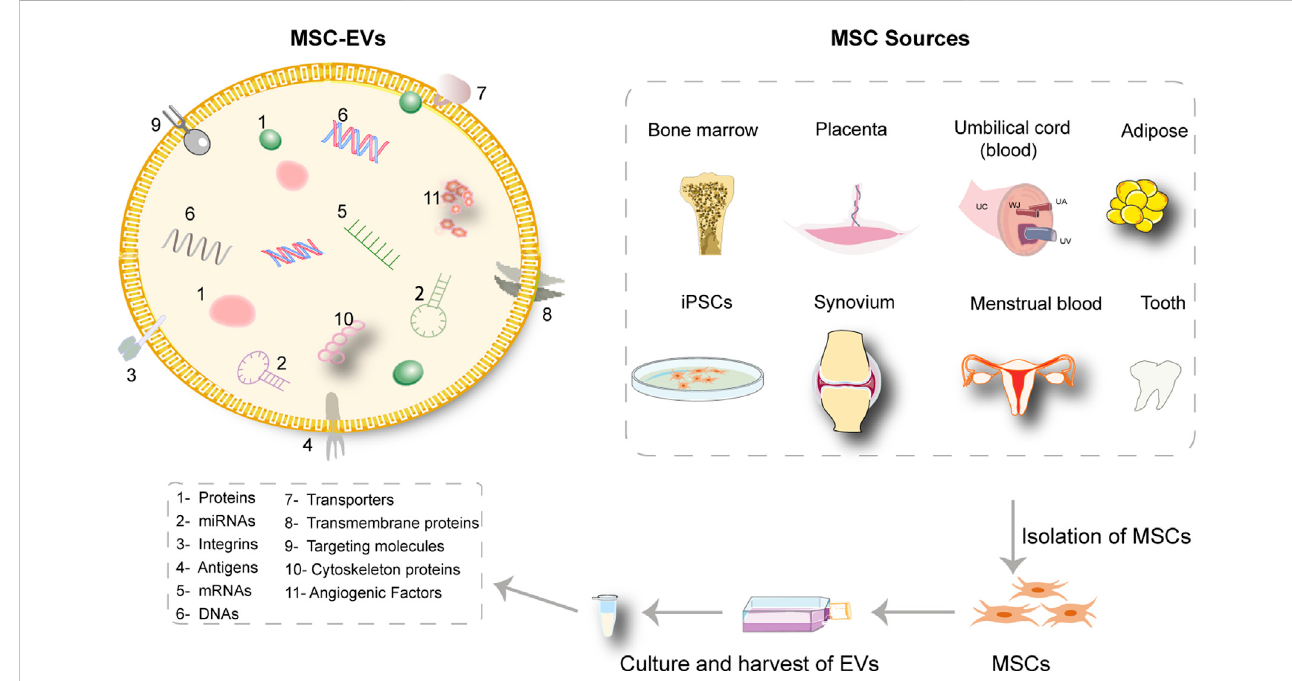
FIGURE 2 The content of MSC-sEVs and extensive sources of MSCs. The isolated sEVs from MSCs are enriched in a large variety of therapeutic molecules. The sources of MSCs are extensive including bone marrow, umbilical cord, placenta, adipose tissue, synovial membrane, exfoliated deciduous teeth, menstrual blood, and induced pluripotent stem cells